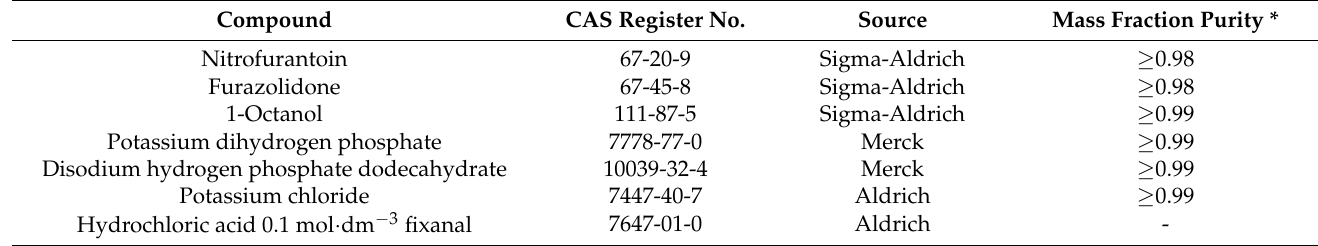
Table 6. List of chemicals used in this